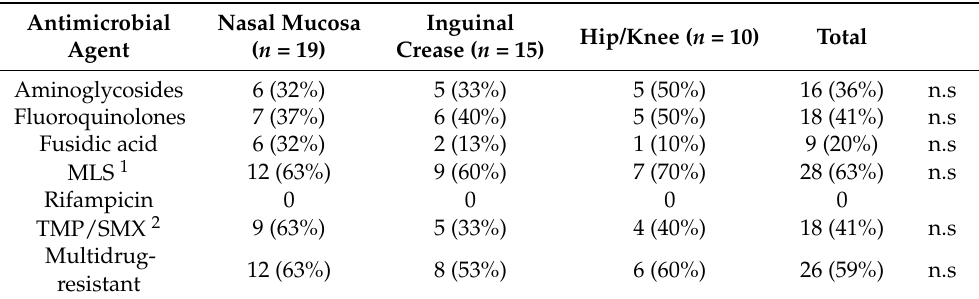
Table 2. Co-resistance (based on the presence of gene(s)/gene variants) to other antimicrobial agents in methicillin-resistant S. epidermidis (MRSE) retrieved from sampling of patients planned for prosthetic joint surgery prior to hospital admission (data are presented as the number (percentage) of samples with resistant MRSE). n.s = not